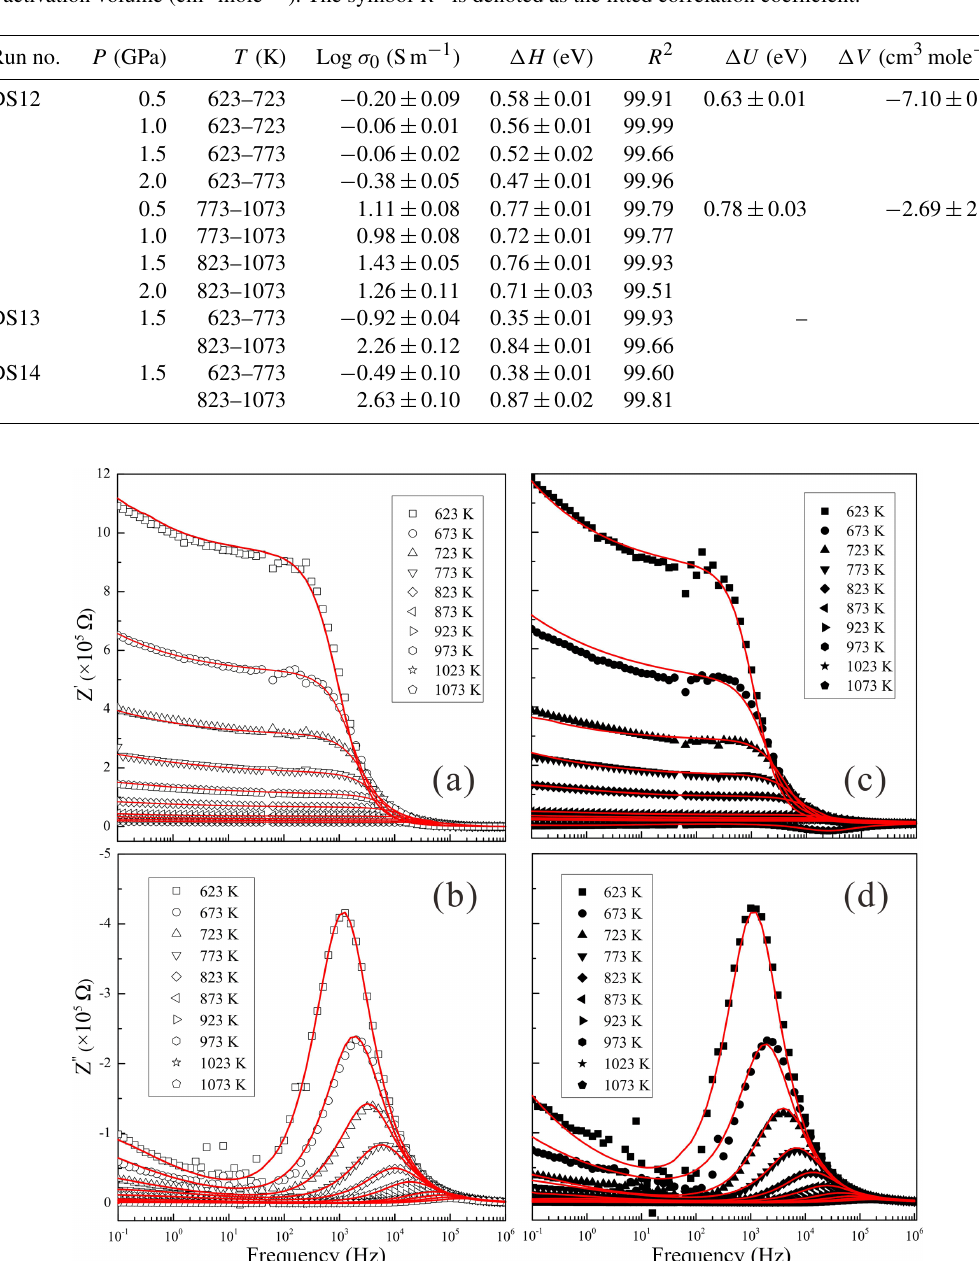
Figure 4. Real and imaginary parts of complex impedance as functions of the measured frequencies for the runs DS13 and DS14 gneiss samples under conditions of 1.5GPa and 623–1073K. (a) real and (b) imaginary parts for the run DS13 gneiss; (c) Real and (d) imaginary parts for the run DS14